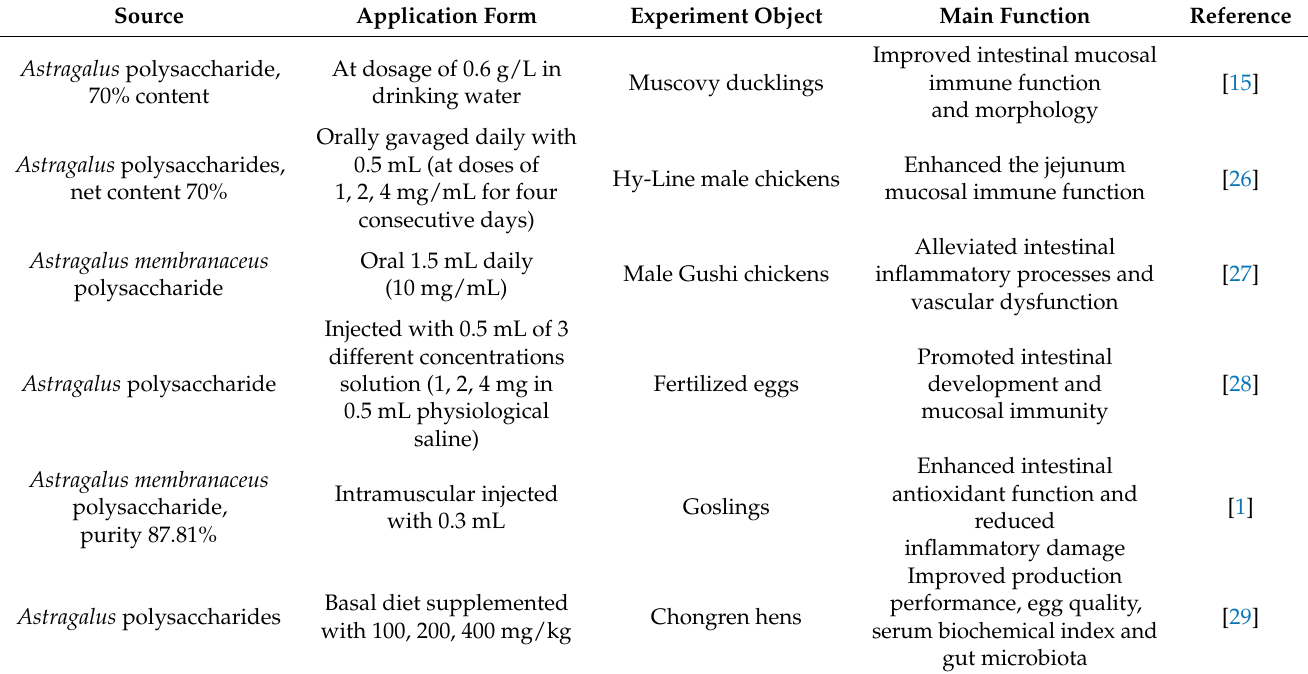
Table 1. Sources of plant-derived polysaccharides applied in poultry